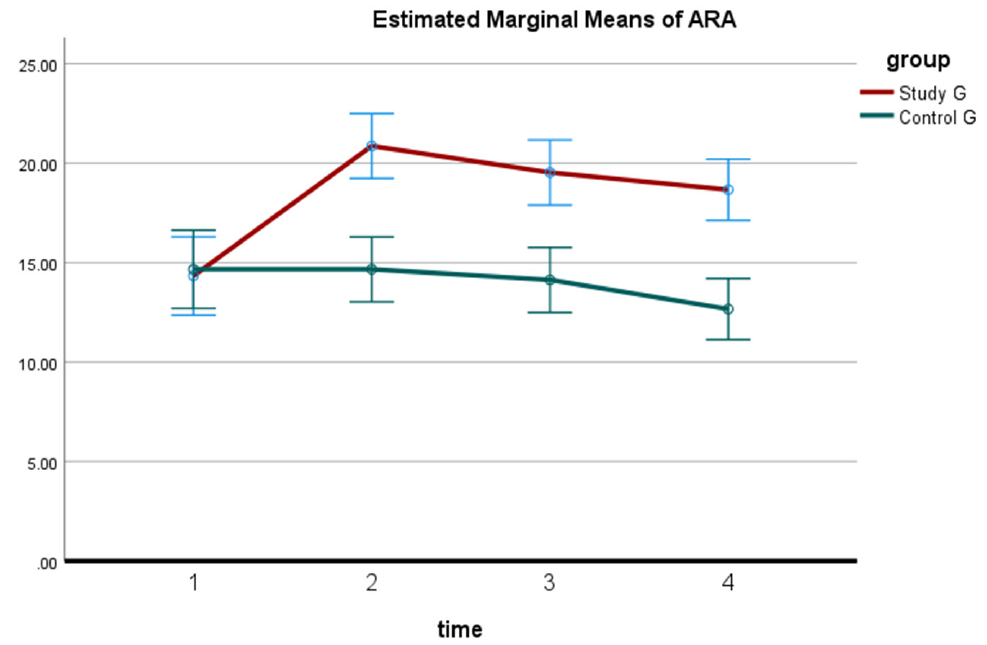
Figure 6. The cervical lordosis absolute rotation angle C2–C7 (ARA) for the control group and study group is shown as the mean ± SD. Four different time periods are shown: baseline or pretreatment, after completion of the 10-week program, the 3-month follow-up, and the 2-year follow-up. 1: pretreatment; 2: 10 weeks post-treatment; 3: at 3 months; 4: at 2-year follow-up. The repeated measures one-way ANOVA, comparing initial DSSEPs to 10-week treat- ment values, identified statistically significant improvements for both groups ( p < 0.0001).